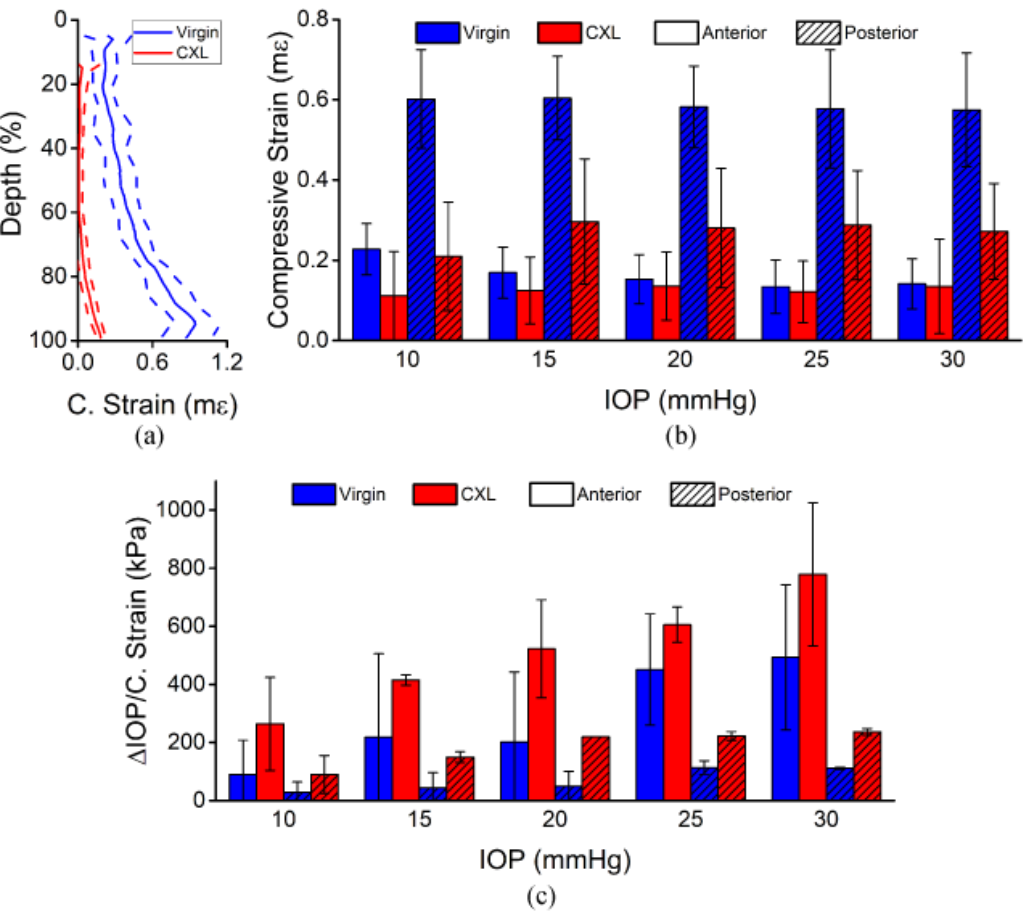
Figure 4. Depth-wise analysis of the in situ rabbit corneas (N = 3). ( a ) Example depth-wise strain averaged across the entire frame for a typical sample before and after CXL at 10 mmHg IOP. The solid line is the average, and the dashed lines show one standard deviation of error. The data was normalized to the full thickness. ( b ) Average compressive strain and ( c ) stiffness quantified by Equation (2) for each region shown as the intra-region mean ± standard deviation.